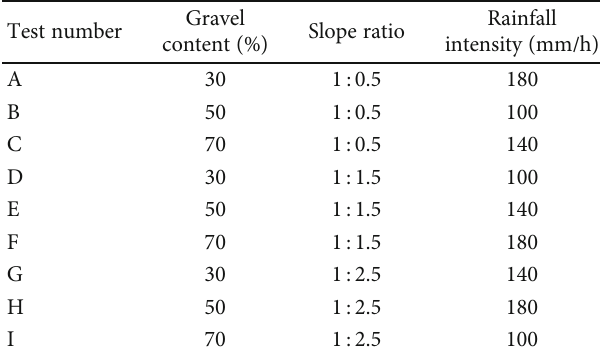
Table 1: Orthogonal test